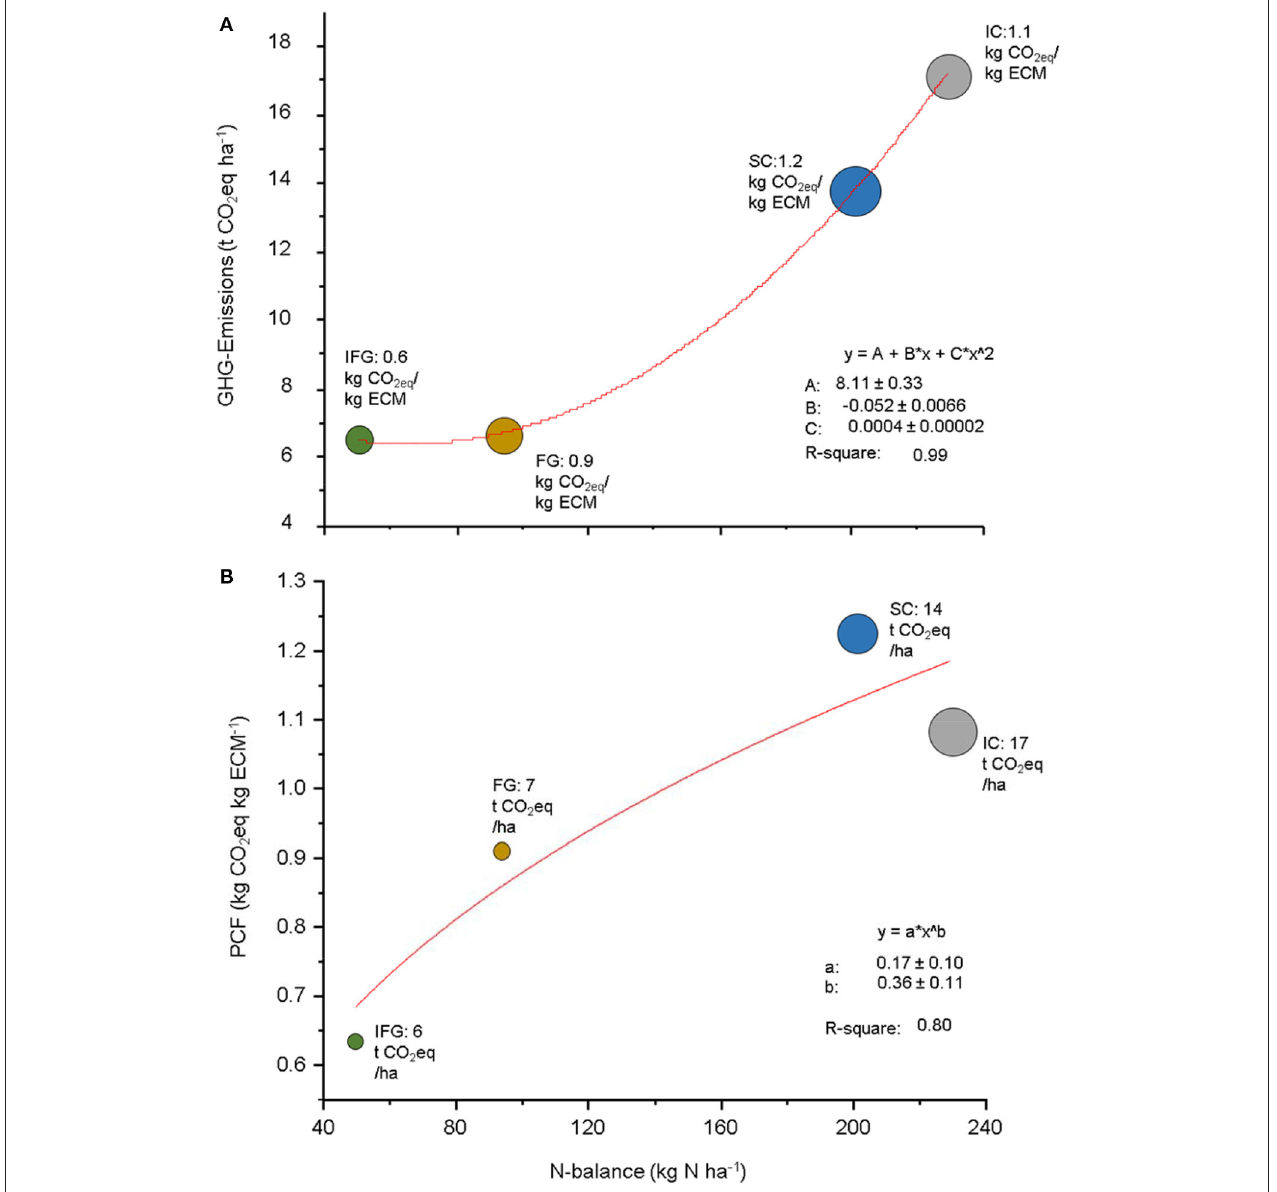
FIGURE 3 | Relationship between the farm-N-balance, GHG-emissions and product carbon footprint (PCF), among the different systems (IC, intensive-confinement; SC, semi-confinement; FG, full-grazing; IFG, integrated full-grazing). Results of the regression analysis are shown. Legends on the bubbles show either the PCF (A) or the GHG-emissions per ha (B)